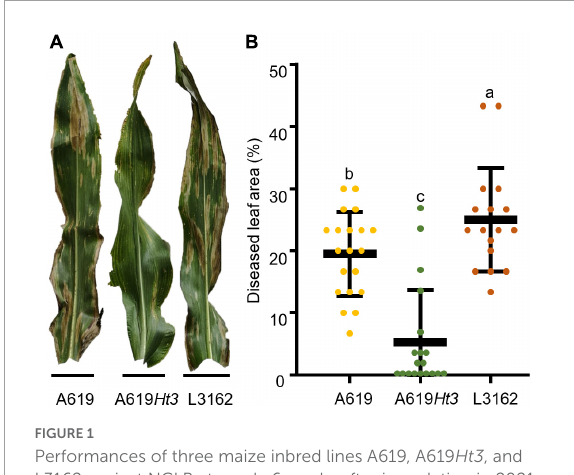
FIGURE1 Performances of three maize inbred lines A619, A619 Ht3 , and L3162 against NCLB at nearly 6 weeks after inoculation in 2021. A619 Ht3 exhibited highly resistant to NCLB, while A619 and L3162 show highly susceptible to NCLB. (A) Symptoms of NCLB on leaves; (B) Diseased leaf area